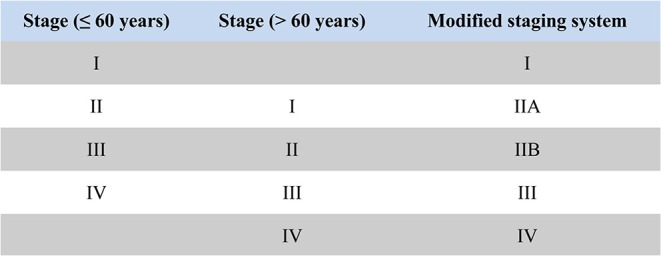
The principle diagram of modifying AJCC TNM staging system based on age: stage I patients under 60 years were classified as stage I in the modified staging system; stage II patients under 60 years and stage I patients older than 60 years were classified as stage IIA in the modified staging system; stage III patients under 60 years and stage II patients older than 60 years were classified as stage IIB in the modified staging system; stage IV patients under 60 years and stage III patients older than 60 years were classified as stage III in the modified staging system; stage IV patients older than 60 years were classified as stage IV in the modified staging system.